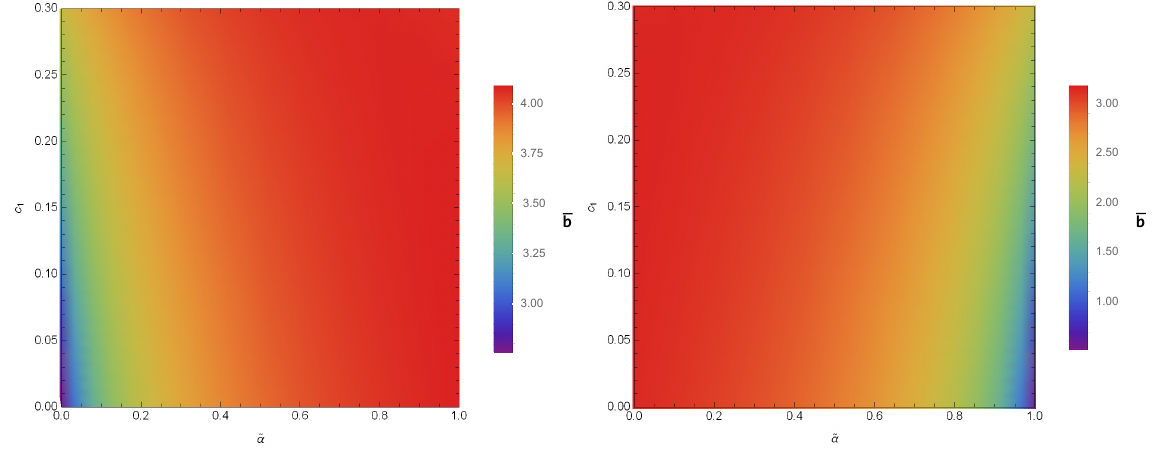
Figure 3. Color-indexed variations of the coefficient (¯ b ) with ˜ α and c 1 ( left ) for PPL and ( right ) for √ PPM. Here, we set c 0 = 3 c 1 d + 1, d = 1, and Λ = −